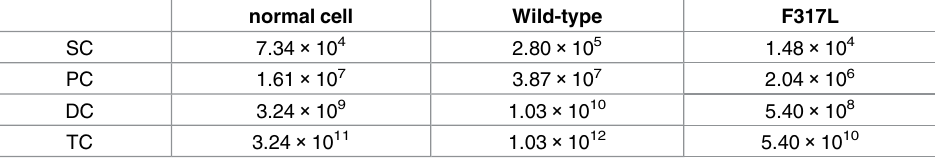
Table 1. The initial cell